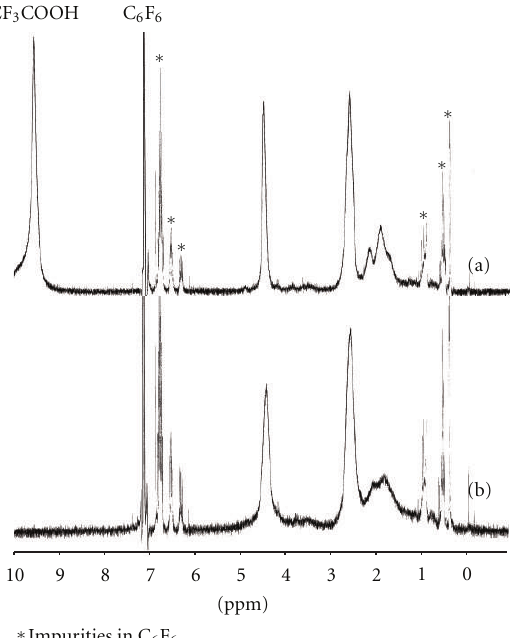
Figure 4: 1 H NMR spectra of P(POA- r -AA) with a 7/3 POA/AA ratio in the presence (a) and absence (b) of CF 3 COOH. Solvent: C 6 F 6 including C 6 D 6 .